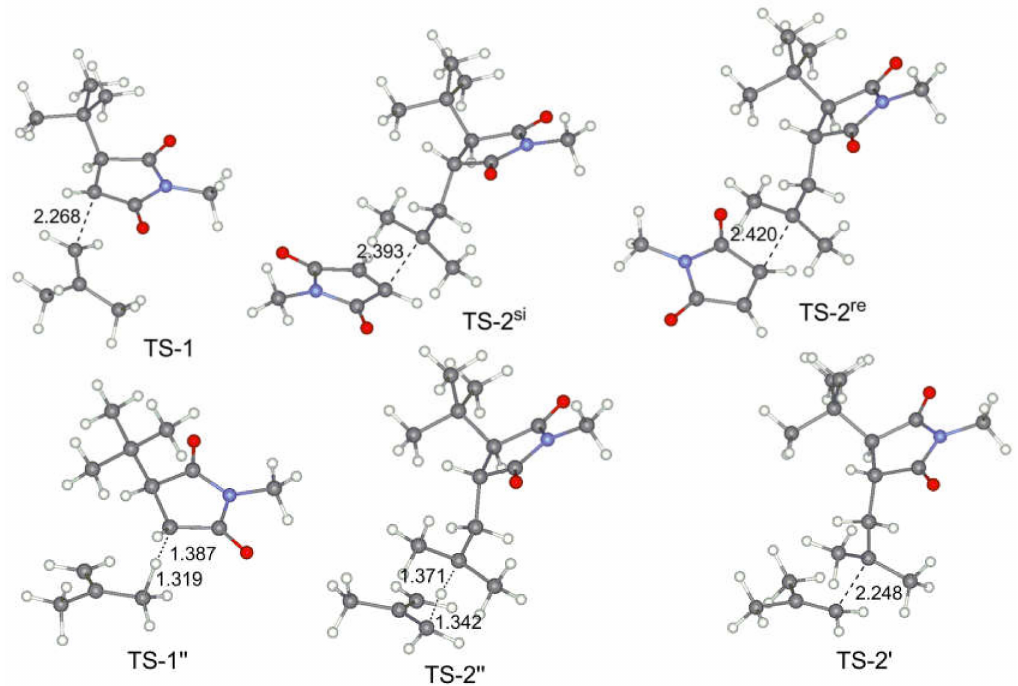
Figure 6. Calculated geometries of the key transition states for MMI–IB